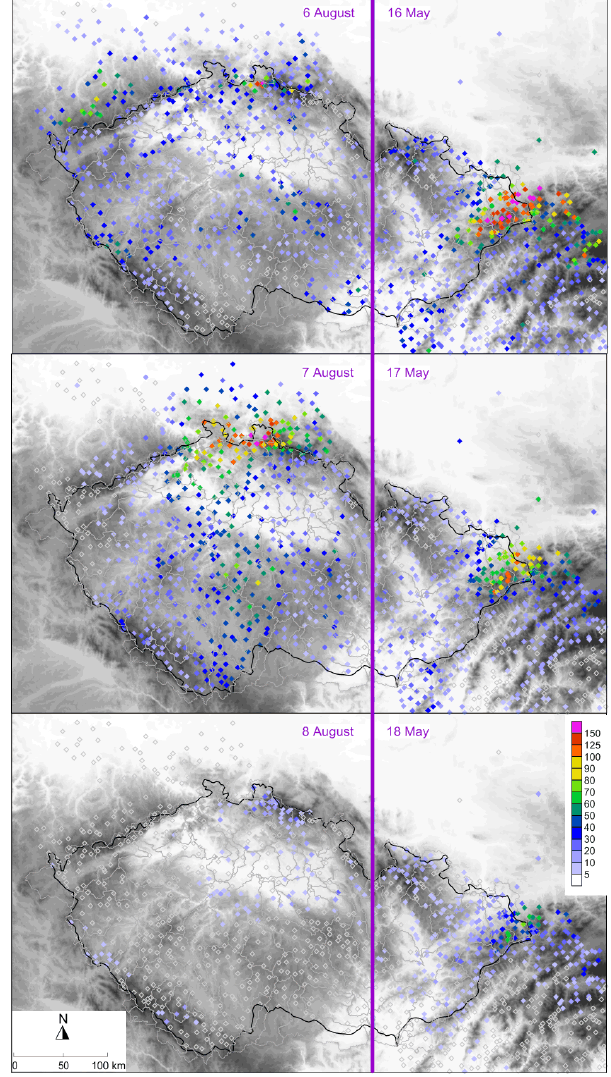
Fig. 2. Daily precipitation totals in May 2010 and in August 2010 (the right and the left part of the figure, respectively). The state border of the Czech Republic is depicted by the black line.